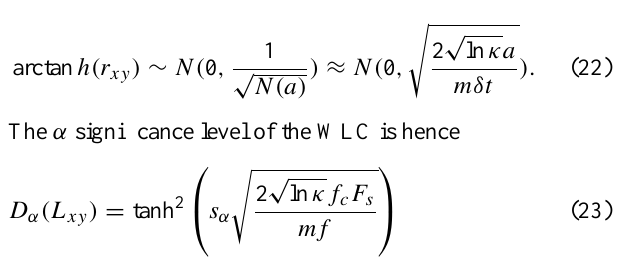
Fig. 3. Decorrelation of wavelet coefficients of a GWN with an in- creasing time separation reflected by the decorrelation of wavelets. The mother Morlet wavelets ψ(t) are used for illustration. The blue and the black wavelets have a correlation coefficient of 1/5 ( κ = 5); the red and the black wavelets have a correlation coefficient of 1/20 ( κ =